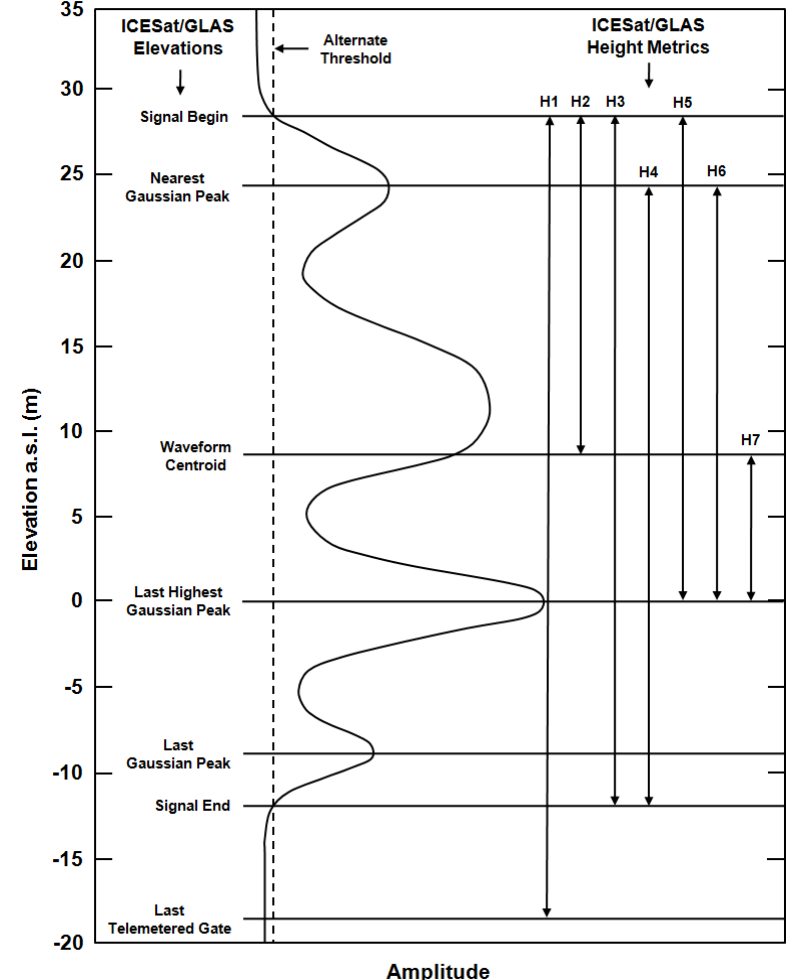
Figure 2. Simplified ICESat/GLAS waveform with four Gaussian peaks. On the left, the location of the different ICESat/GLAS elevations is depicted and, on the right, the varying ICESat/GLAS height metrics derived from them are shown. The Signal Begin and the Signal End of the waveform are defined by the crossing of an Alternate Threshold (dashed